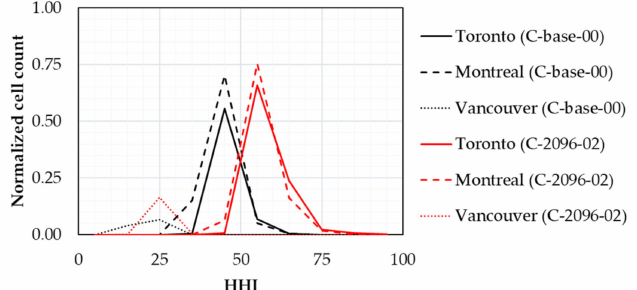
Figure 4. Normalized (to the maximum overall cell count of the three cities) histogram of HHI of comparing the current state (C-base-00) and the worst-case scenario (C-2096-02) among Toronto, Montreal, and